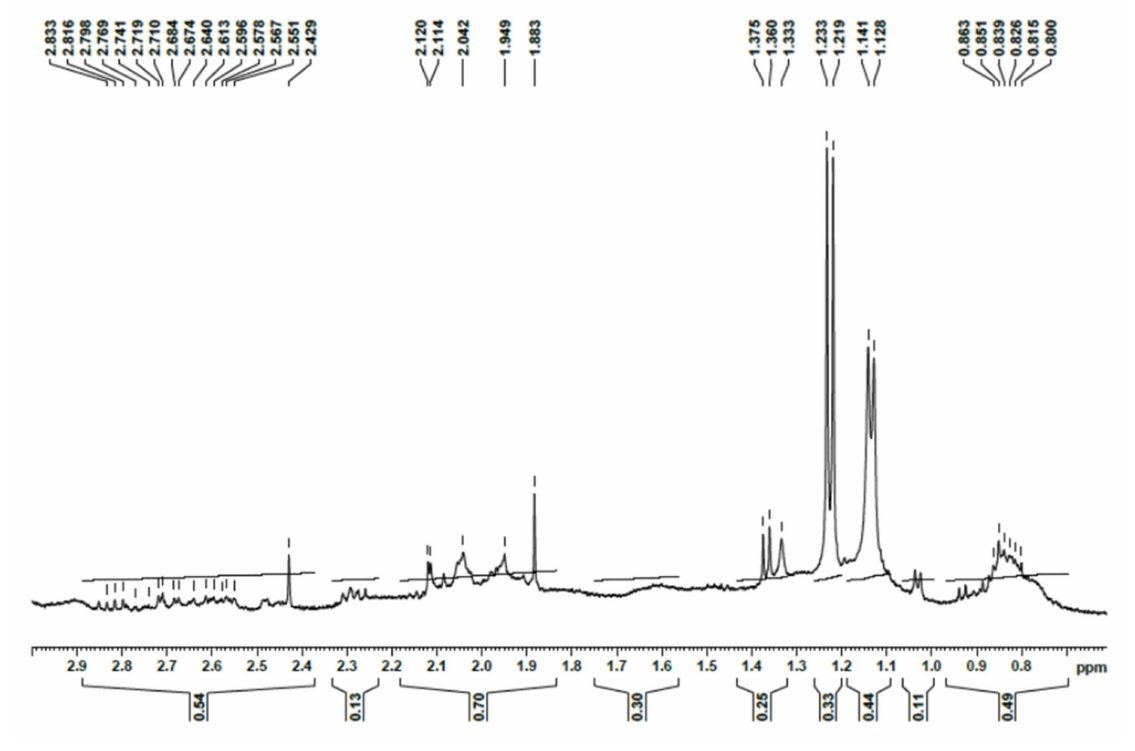
Figure A2. 1 H spectra of